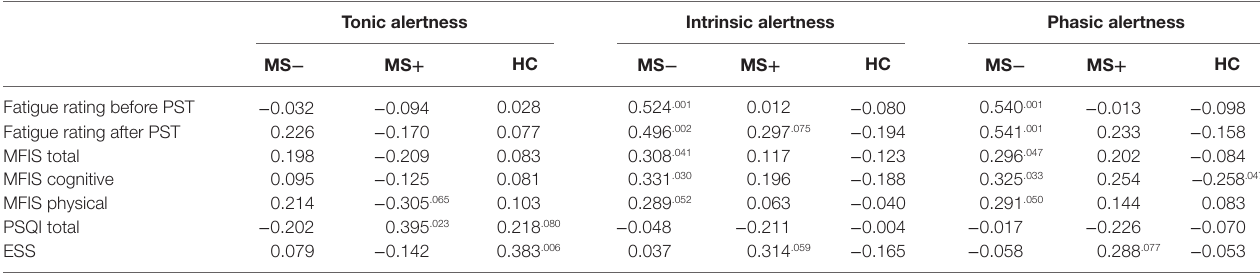
TaBle 3 | Correlations of self-report and performance-based measures for MS patients without (MS − ) and with (MS + ) comorbid disorders in comparison to healthy controls (HC). Tonic